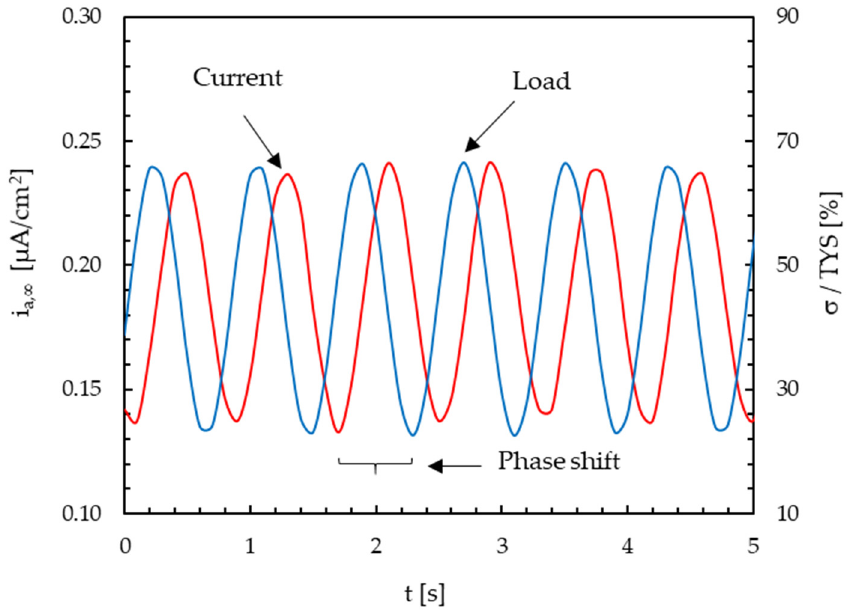
Figure 5. Steady state anodic current (amplitude = ± 20% tensile yield strength (TYS), frequency = 1 Hz) in function of an alternate component of loading.